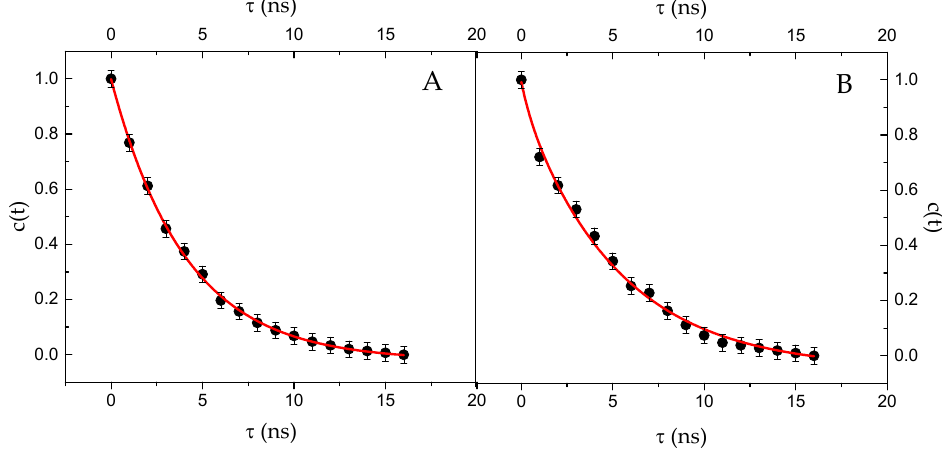
Figure 5. Temporal behaviour of c ( t ) function for the short-wavelength fluorescence band of I ( A ) and II ( B ) in phosphate buffer solution with BSA (c BSA = 10 − 6 M).